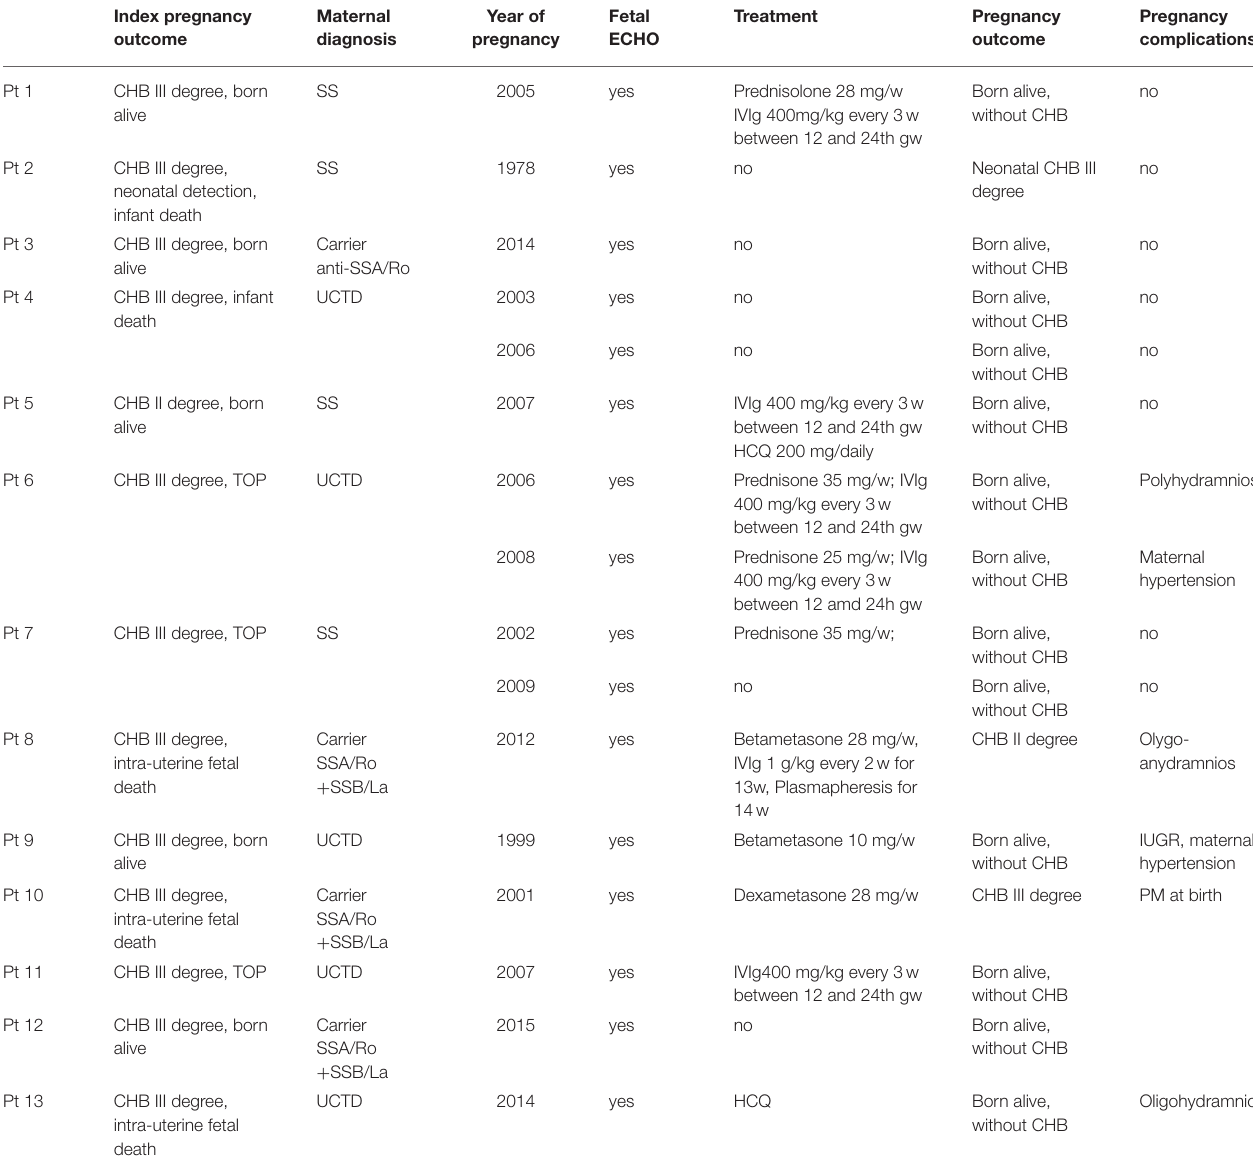
TABLE 7 | Subsequent pregnancies after an index pregnancy complicated with CHB: treatment and pregnancy